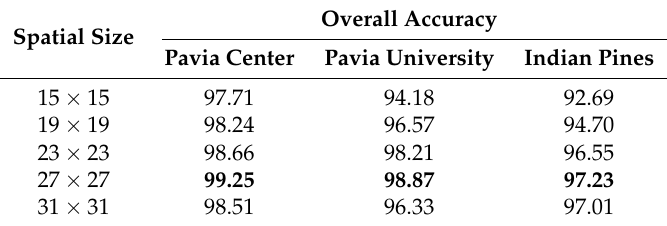
Table 5. Overall accuracy (OA) of the proposed method with different spatial sizes.